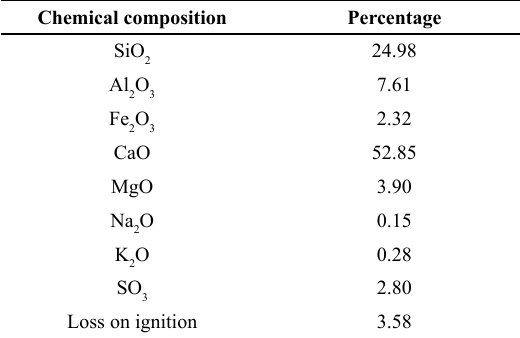
Table 2. Chemical composition of the cement.